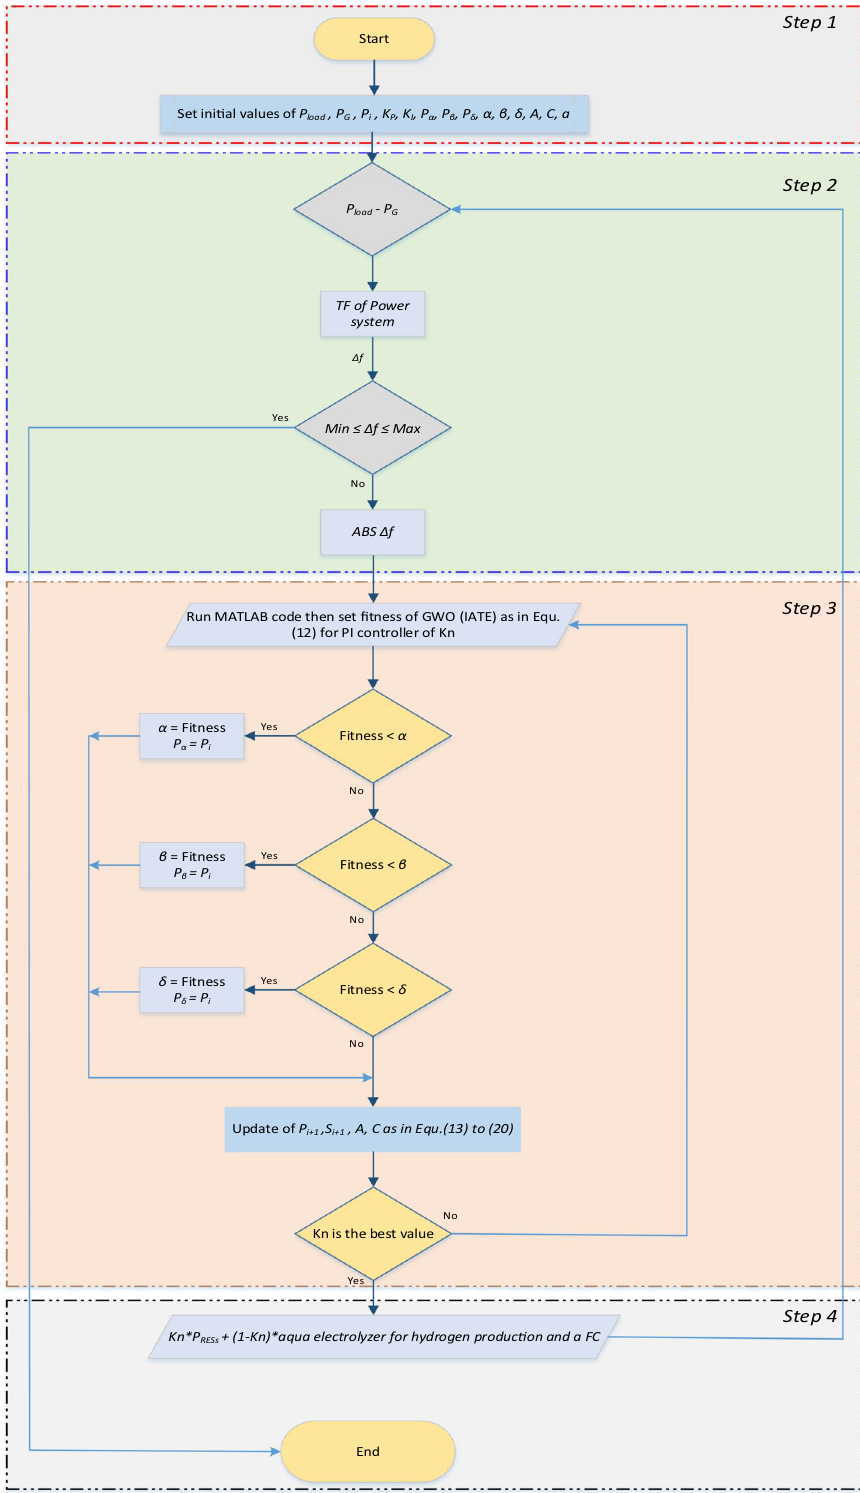
Fig. 4 Flowchart of the complete proposed